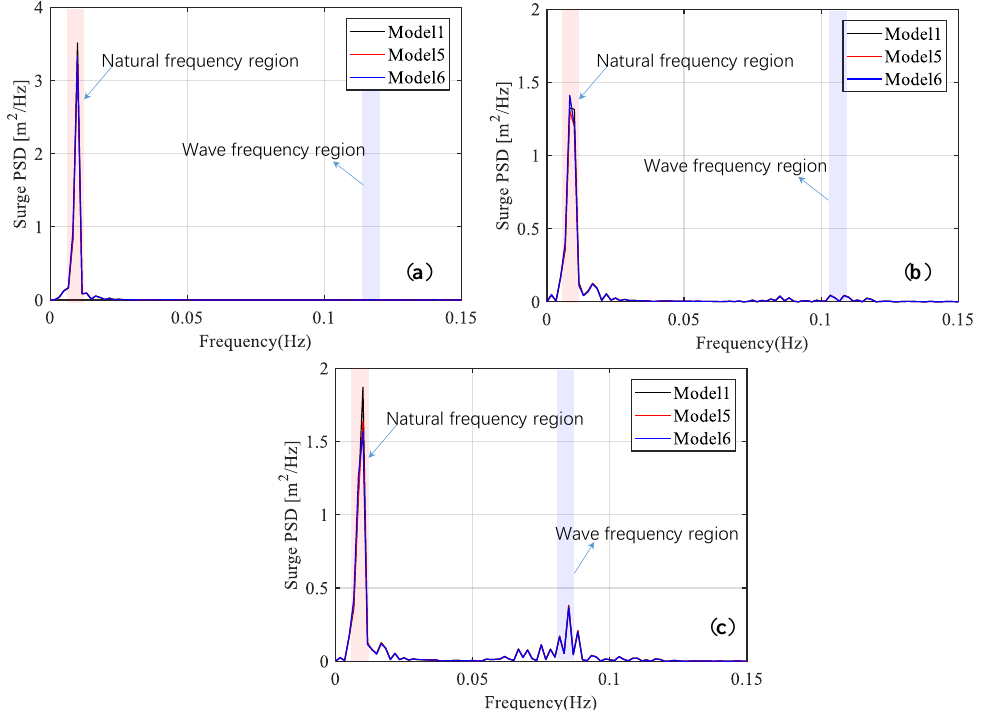
Figure 17. Frequency domain curves of the surge PSD of the inclined upper column models: ( a ) LC4; ( b ) LC5; and ( c ) LC6.